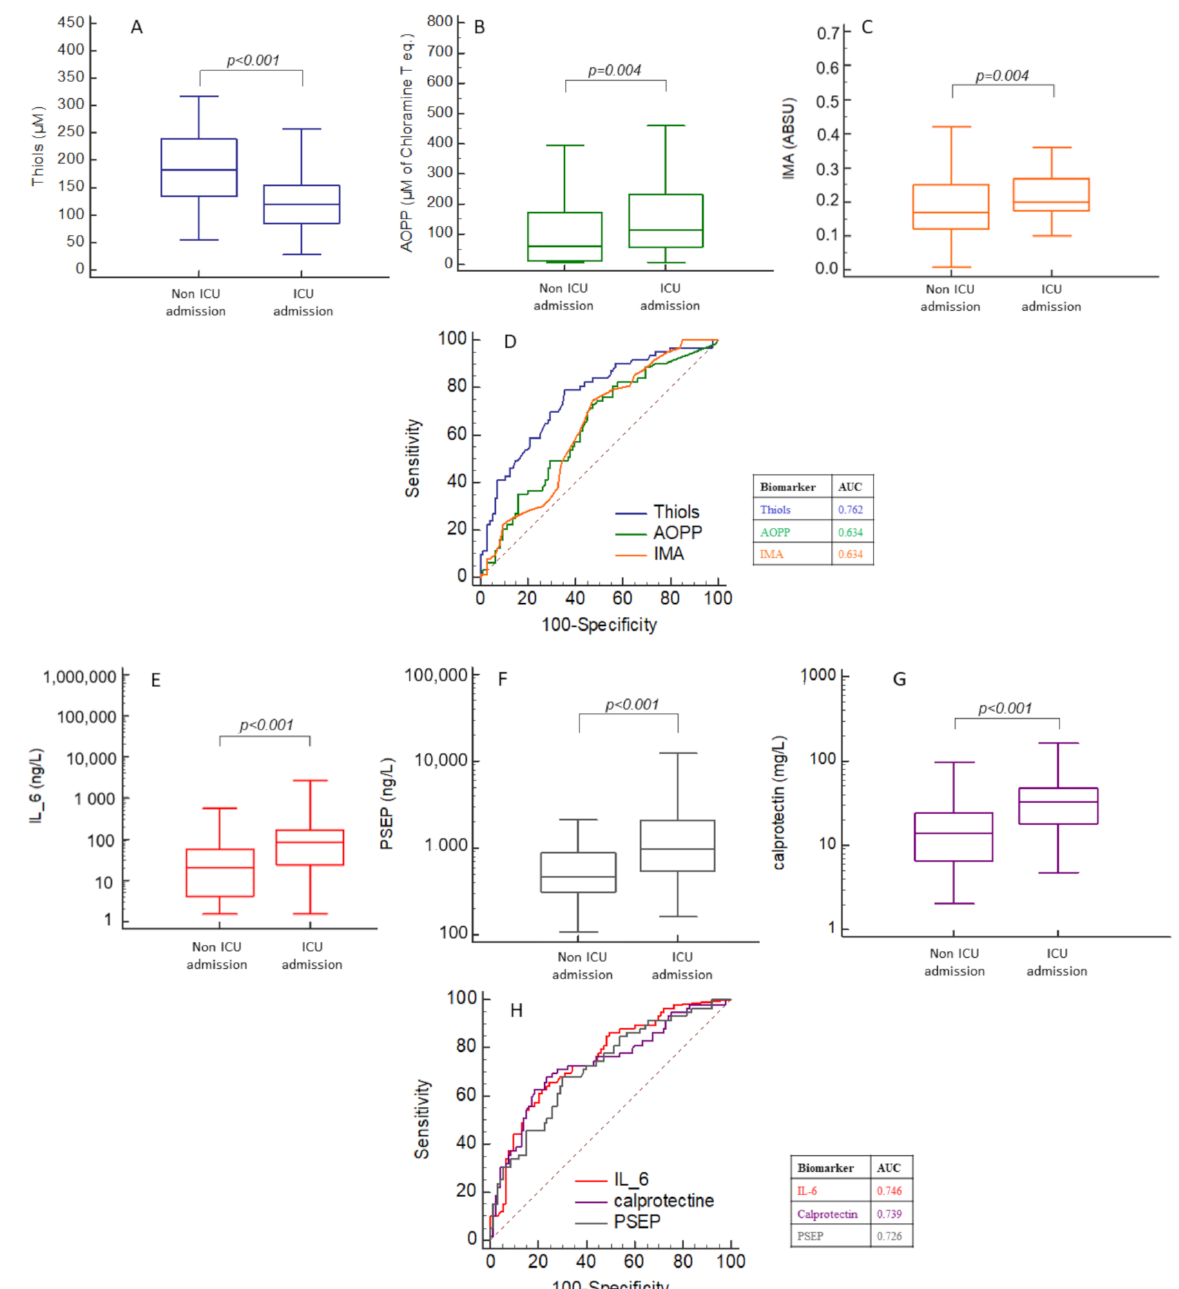
Figure 2. Box-plots and receiver operating characteristics (ROC) curve analysis of oxidative stress (OS), inflammation and cell-activation biomarker concentrations for the prediction of ICU admission. ( A – C ), thiols, AOPP and IMA concentrations according to ICU admission; ( D ) thiols AOPP and IMA ROC curves and AUC values; ( E – G ) IL-6. presepsin, calprotectin concentrations according to ICU admission; ( H ) IL-6, presepsin, calprotectin ROC curves and AUC